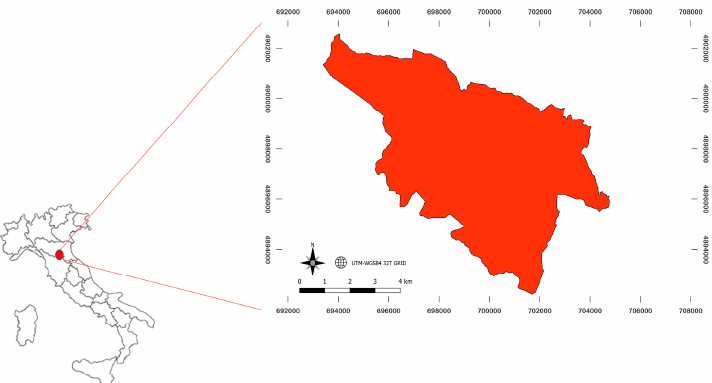
Figure 1. Study area: the Municipality of Castel del Rio, located in the Emilia ‐ Romagna Region,